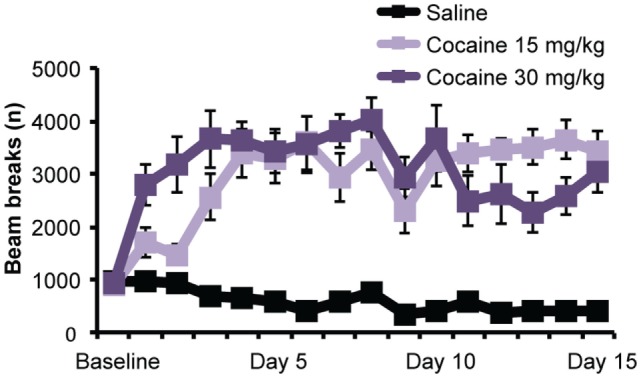
Cocaine sensitization. Chronic exposure to cocaine (15 and 30 mg/kg) significantly increased locomotor activity over days. Photobeam breaks mean (±SEM).